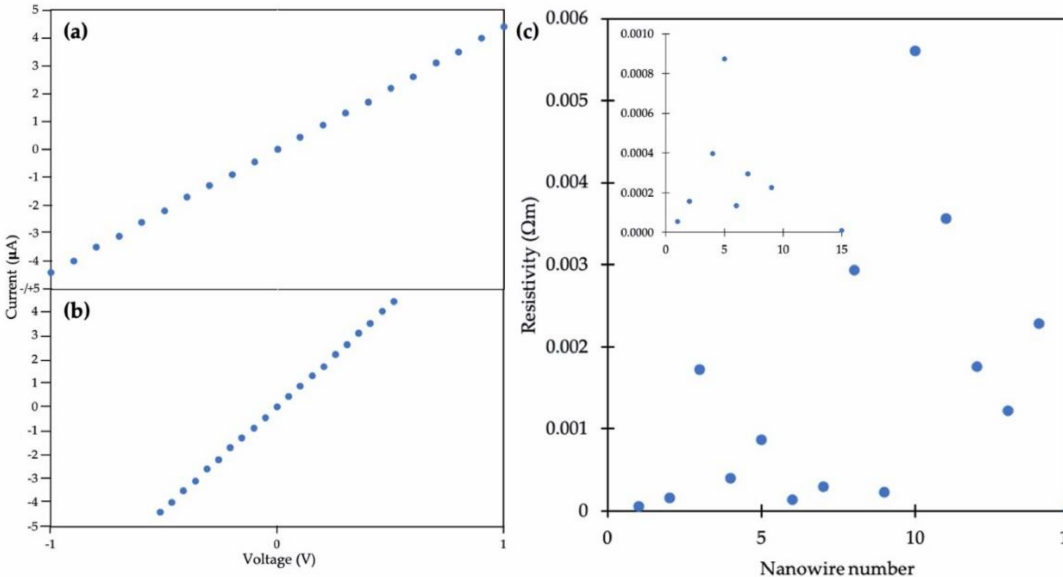
Figure 7. Electrical measurements on a plated DNA nanotube Au nanowire. ( a ) Two point I-V curve. ( b ) Measured voltage drop between inner electrodes during four-point measurement. ( c ) Scatter plot for resistivity values measured. (Inset) Expanded y-axis view from 0 to 0.001 Ω